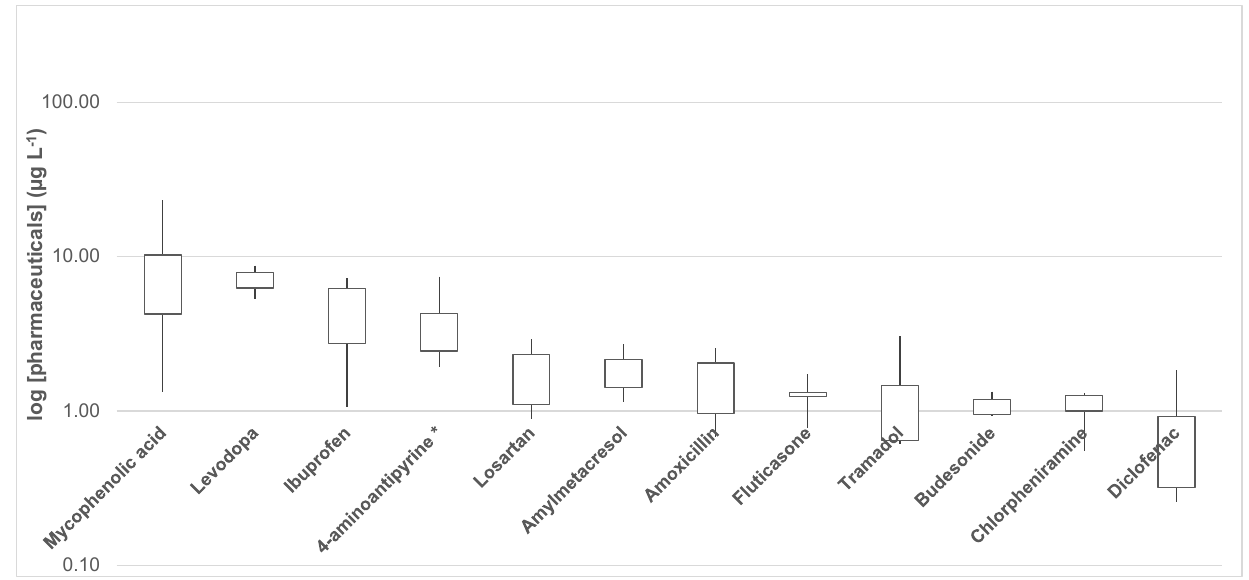
Figure 2. Boxplot in logarithmic scale (in µg L -1 ) of eleven pharmaceuticals with highest concentrations in the 10 wastewater samples. * 4-aminoantipyrine is a metabolite of aminopyrine.